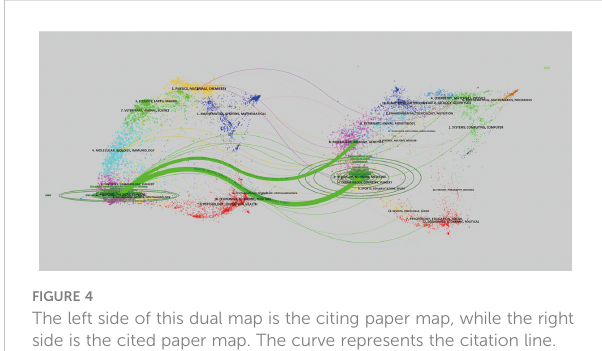
FIGURE 4 The left side of this dual map is the citing paper map, while the right side is the cited paper map. The curve represents the citation line. On the left side, the horizontal and vertical ellipse axes re fl ect publications and authors in corresponding